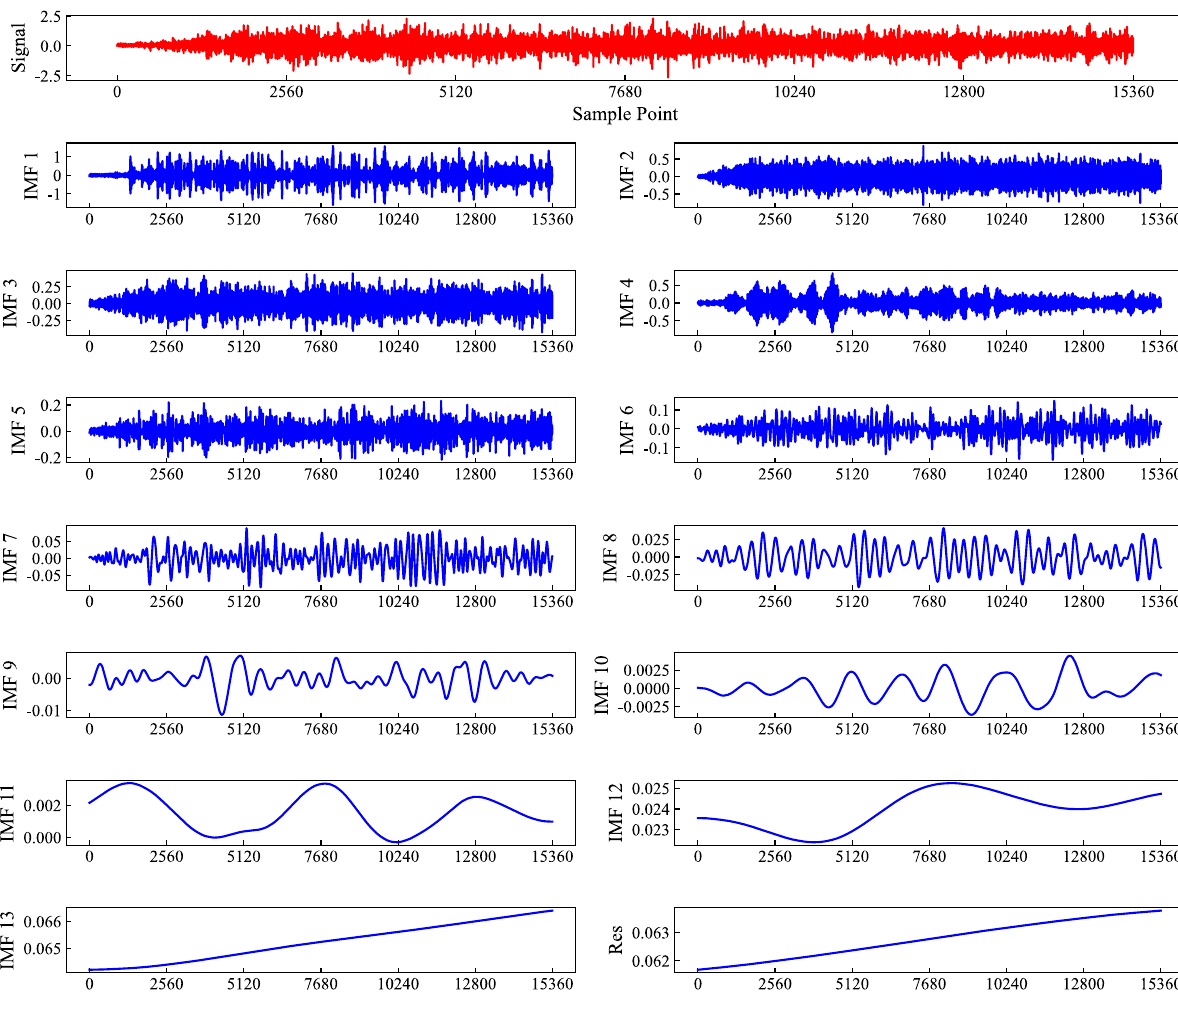
Figure 7. Decomposition of the white noise dataset.